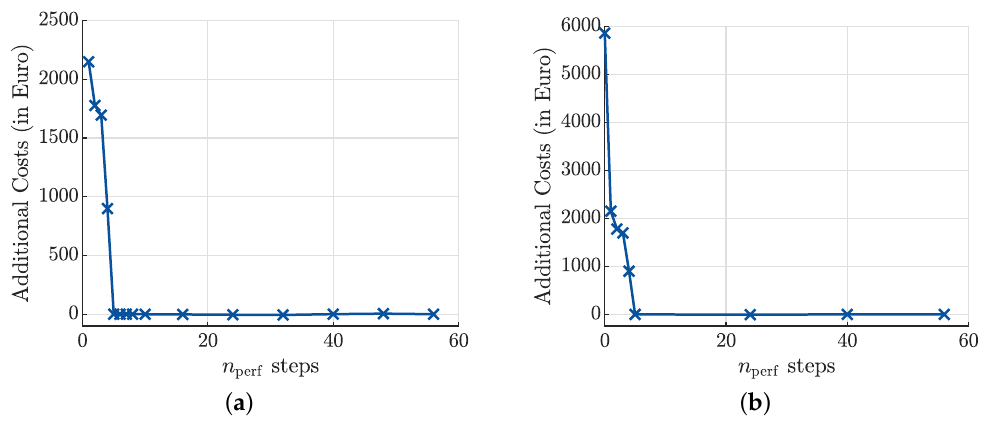
Figure 9. Additional costs in comparison to perfect simulation when the first n perf steps of the prediction horizon are perfectly predicted. For both scenarios, additional costs are avoided for n perf ≥ 5. ( a ) Optimistic Scenario; ( b ) Pessimistic